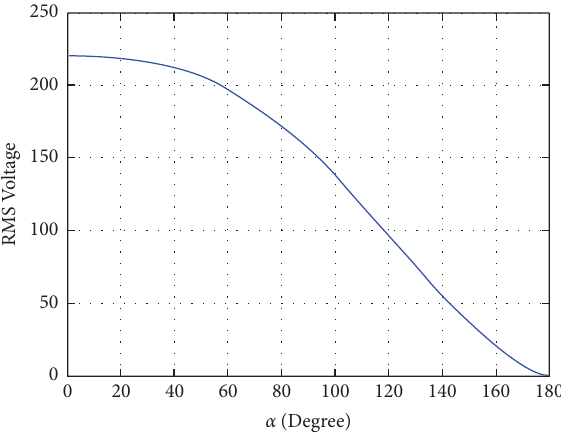
Figure 13: Variation of V Table 7: Power consumed by the heater, bulb, and